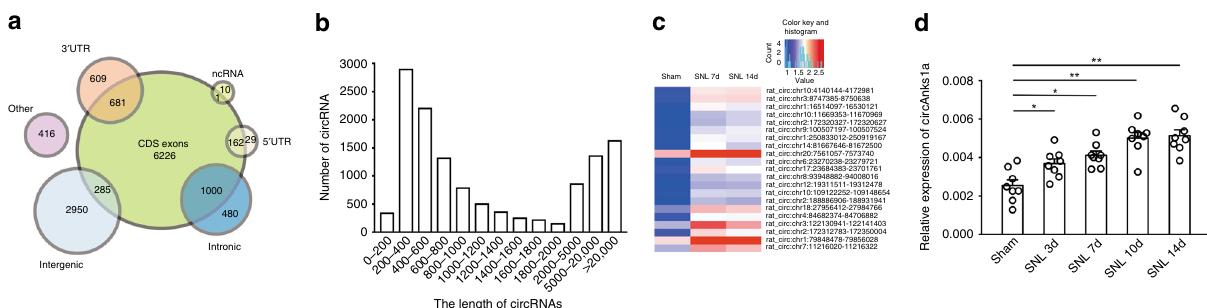
Fig. 1 Pro fi ling the circRNAs in spinal dorsal horn of rats. a Genomic origin of circRNAs. b The length distribution of circRNAs. c Heat map of the top 21 increased circRNAs on days 7 and 14 following SNL treatment. d Relative expression level of circAnks1a in spinal dorsal horn at various time points after SNL treatment ( * P < 0.05, ** P < 0.01 vs. the sham group, two-tailed one-way ANOVA, n = 8). The data are presented as the mean ± s.e.m. Source data